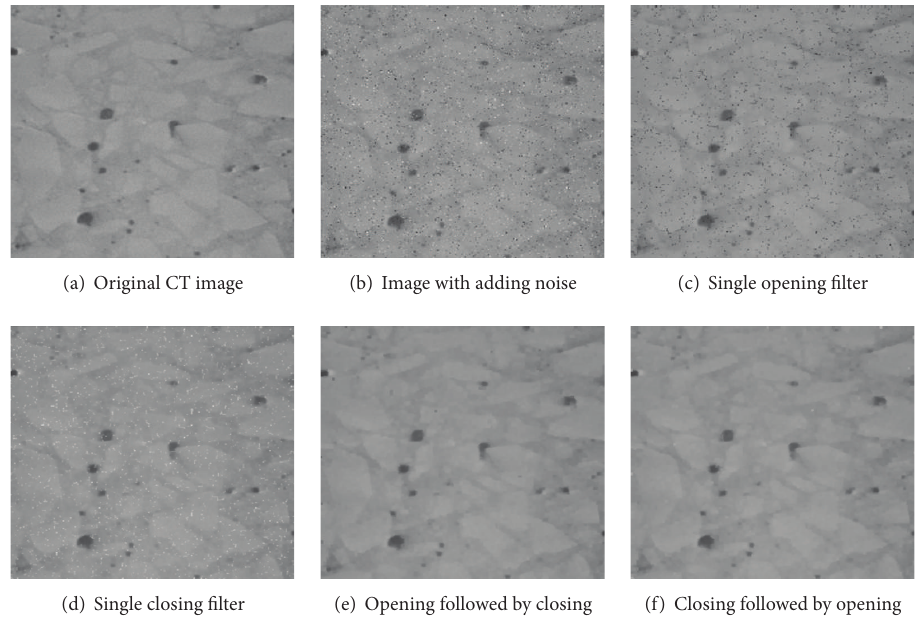
Figure 6: Comparisons of filtering performance using the above morphological operators with a 3 × 3 cross structuring element.